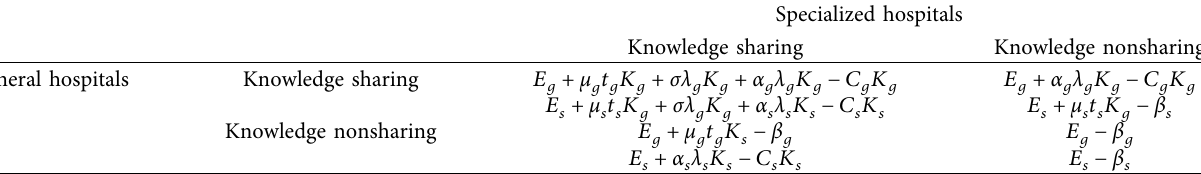
Table 1: The benefit matrix of hospital knowledge sharing under the background of Telemedicine